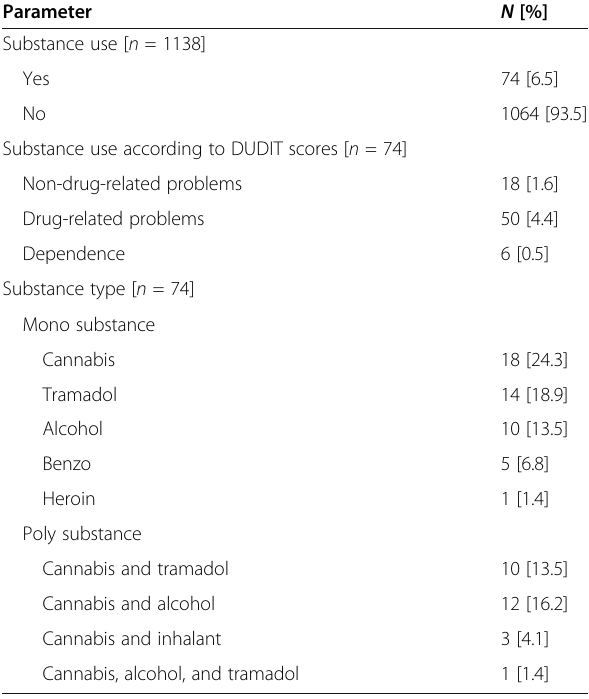
Table 2 Prevalence of substance use and DUDIT score among